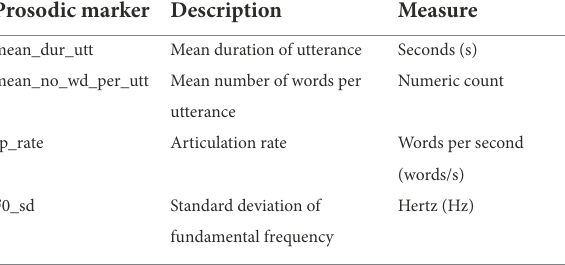
TABLE 3 The four prosodic patterns used for analysis. Prosodic marker